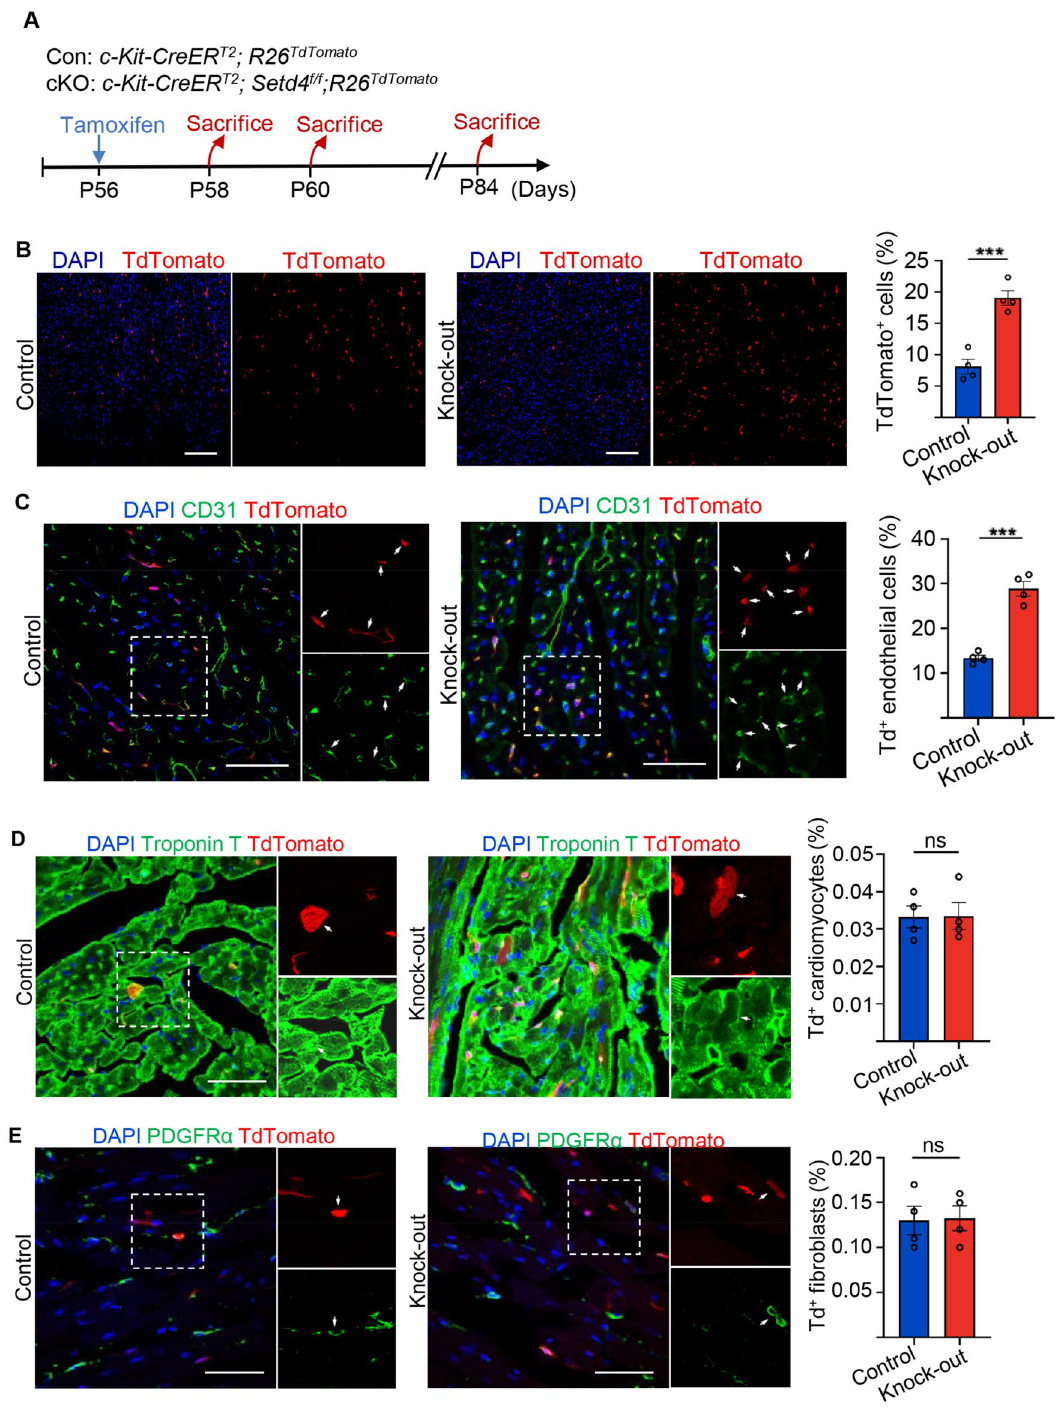
Figure 4. Knock-out of Setd4 induced generation of newborn ECs in adult mice. ( A ) Experimental outline for lineage tracing of adult mice after knock-out of Setd4 . ( B ) Representative immunofluorescence and quantification for recombinant cells after four weeks of Setd4 knock-out. Scale bars = 200 μm. ( C–E ) Identification and quantification for c-Kit + cell-derived ECs (Td + CD31 + ) ( C ), cardiomyocytes (Td + Troponin T + ) ( D ) and fibroblasts (Td + PDGFRα + ) ( E ) after four weeks of Setd4 knock-out. Scale bars = 50 μm. Arrows indicate recombined cells and positive staining. Nuclei were stained with DAPI. All data are represented as mean ± SEM. n = 4 mice. Comparison of independent variables was conducted by two-tailed unpaired Student’s t test. *** p < 0.001, ns: not